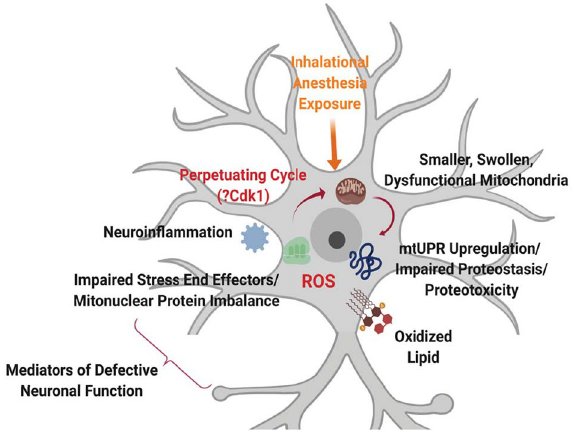
Figure 8. Early-life sevoflurane exposure can induce perpetuating neuronal dysfunction in the adult brain. Our findings indicate that anesthesia exposure in the developing brain adversely alters cellular energetic function through changes to mitochondrial morphology and function, resulting in a lasting adverse shift in mitochondrial quality control and regeneration/biogenesis pathways. This mechanism allows poorly functional organelles to persist, inducing proteotoxicity, oxidative stress, and neuroinflammation, creating a cell non- autonomous propagation of the phenotype, potentially through Cdk1.Image created using